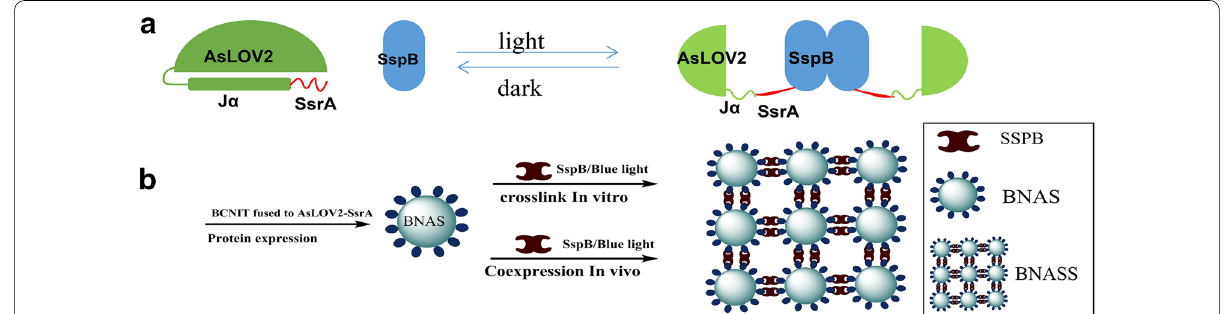
Fig. 1 Schematic design of assembly and disassembly. a Schematic design of the improved light-inducible dimer system. b Strategy for the light-controlled dodecamer assembly and disassembly of nitrilase from Burkholderia cenocepacia J2315 (BCNIT) in cell-free solution (in vitro) and in Escherichia coli (in